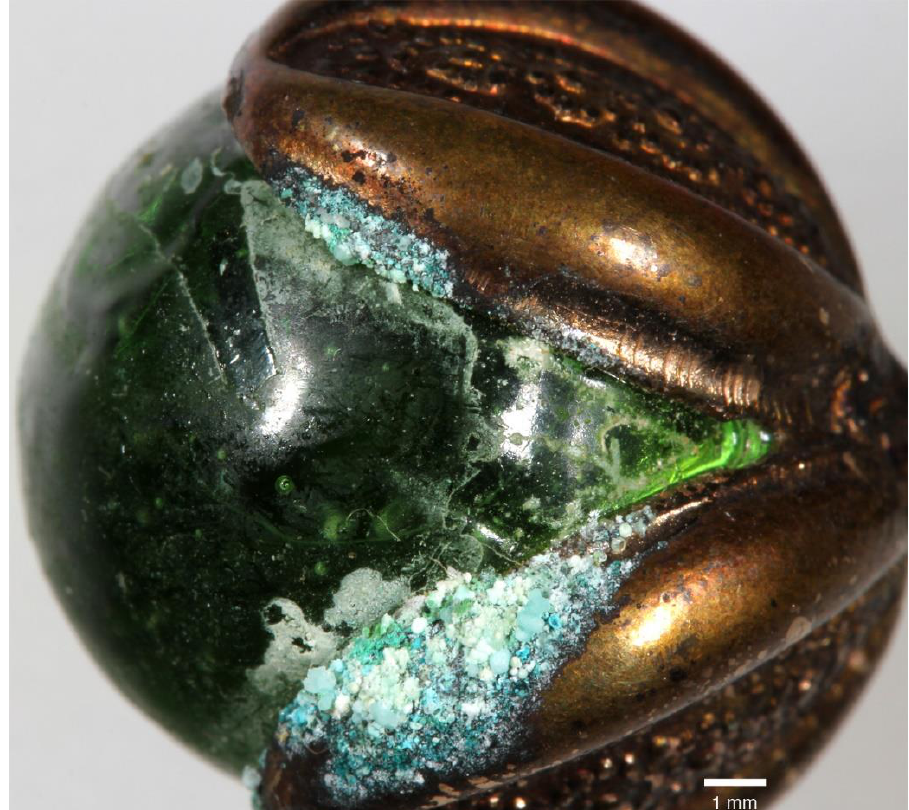
Figure 5. Detail of a hat pin, Museumslandschaft Hessen Kassel, Inv. Nr. MHK-Sch58b, with GIMME corrosion including ④ .